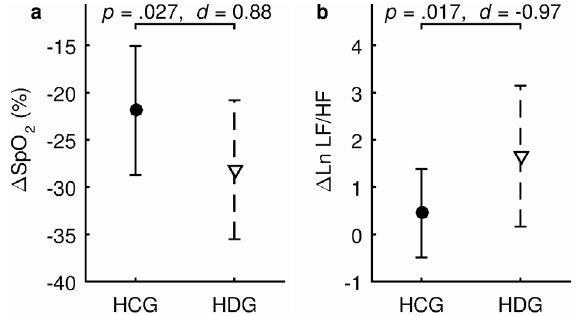
Figure 4. Differences in the oxygen desaturation (a, ΔSpO = SpO – SpO ) and natural loga- 2 2 Hypoxia 2 Preliminary rithm of low-frequency/high-frequency ratio change (b, ΔLn LF/HF = Ln LF/HF – Ln LF/HF ) Hypoxia Preliminary between hypoxia comfort group (HCG, n = 14) and hypoxia discomfort group (HDG, n 14). Values are presented as the mean ± standard deviation. The com- parison by means of two-sample t-test is